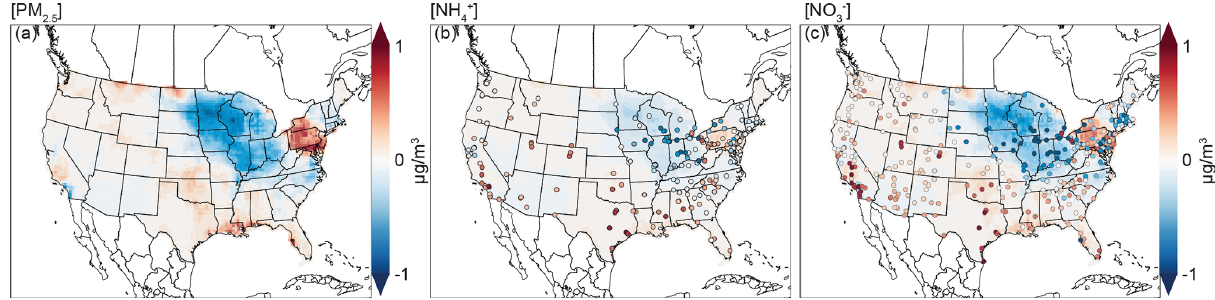
Figure 5. The changes in monthly average PM 2 . 5 , NH + , and NO − mass concentration in April due to the NH 3 emission adjustment in 4 3 the optimized estimates. The change is defined as conc optimized − conc apriori , where conc optimized and conc apriori represent the simulated monthly average mass concentration using the optimized and a priori NH 3 emission estimates, respectively. The difference between the observed NH + and NO − mass concentration and simulated concentrations using the a priori NH 3 emission (conc obs − conc apriori , where 4 3 conc obs represents the observed monthly average mass concentration) is overlaid using colored dots with the same color scheme.